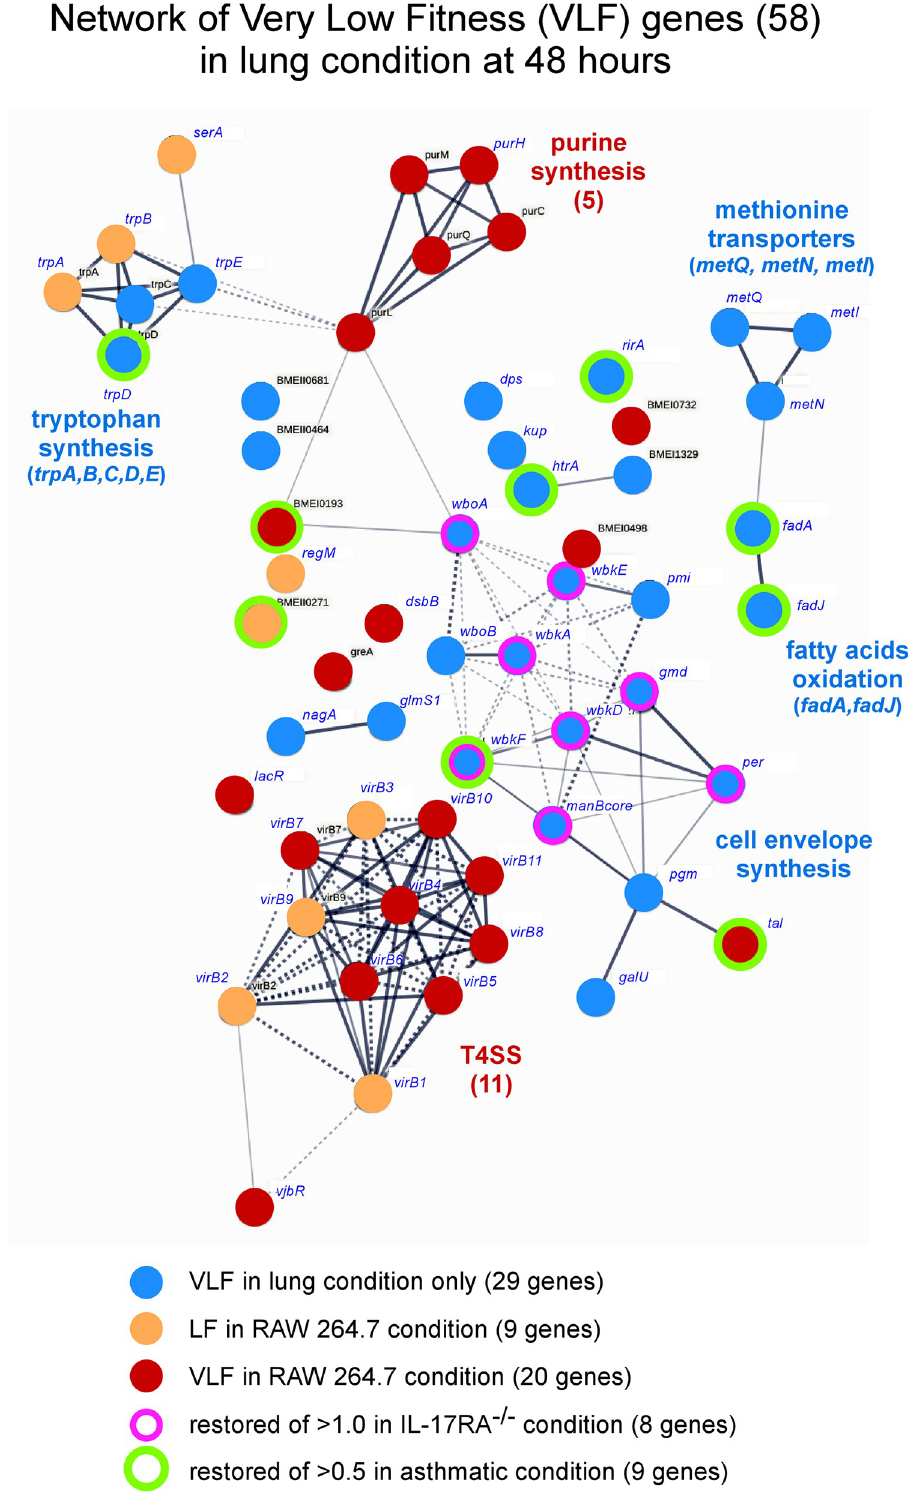
Fig 6. Clustering analysis of very low fitness genes in the lung condition at 48 hours post-infection. The diagram shows the potential interactions between the 58 genes displaying a Δ TnIF < -1.0 identified in lungs of wild-type mice at 48 hours post-infection. The color code of the legend indicates whether the genes are specifically attenuated in